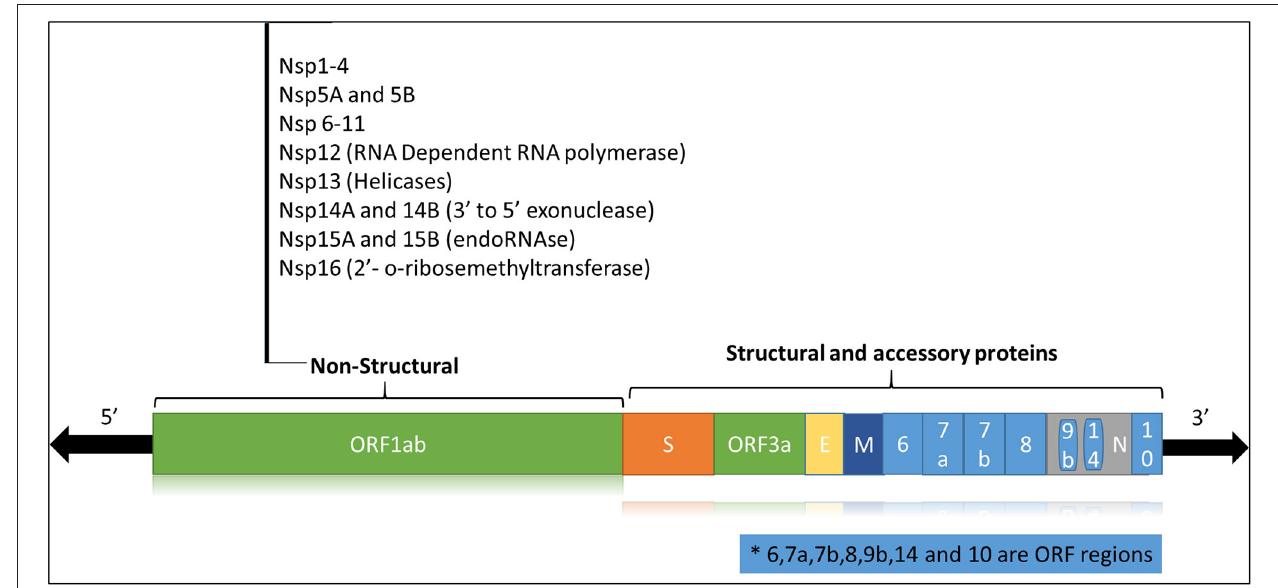
FIGURE 1 | Schematic representation of the SARS-CoV-2 viral